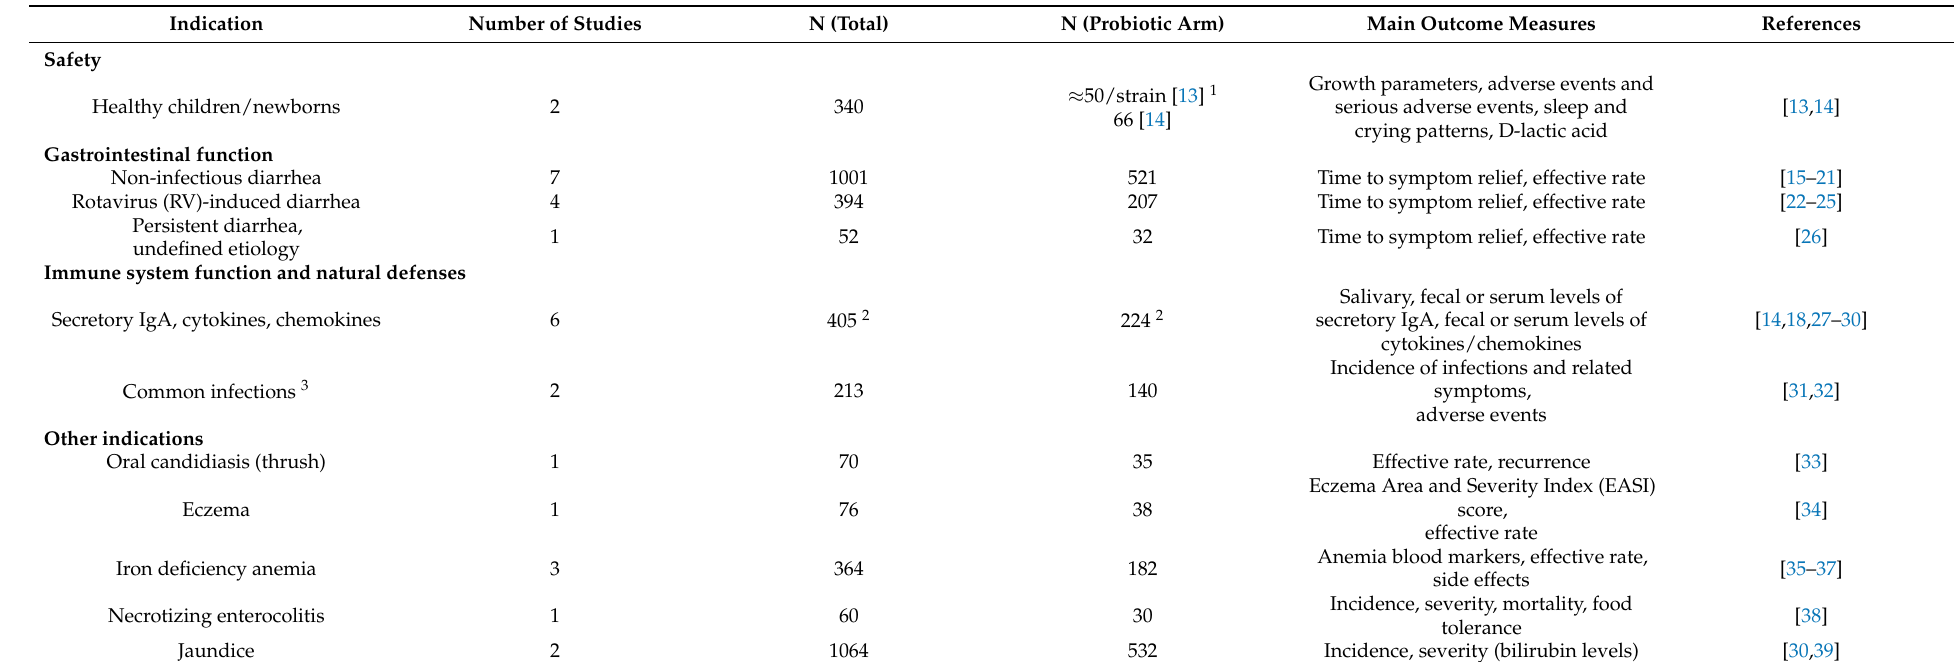
Table 1. Overview of the clinical studies in pediatric